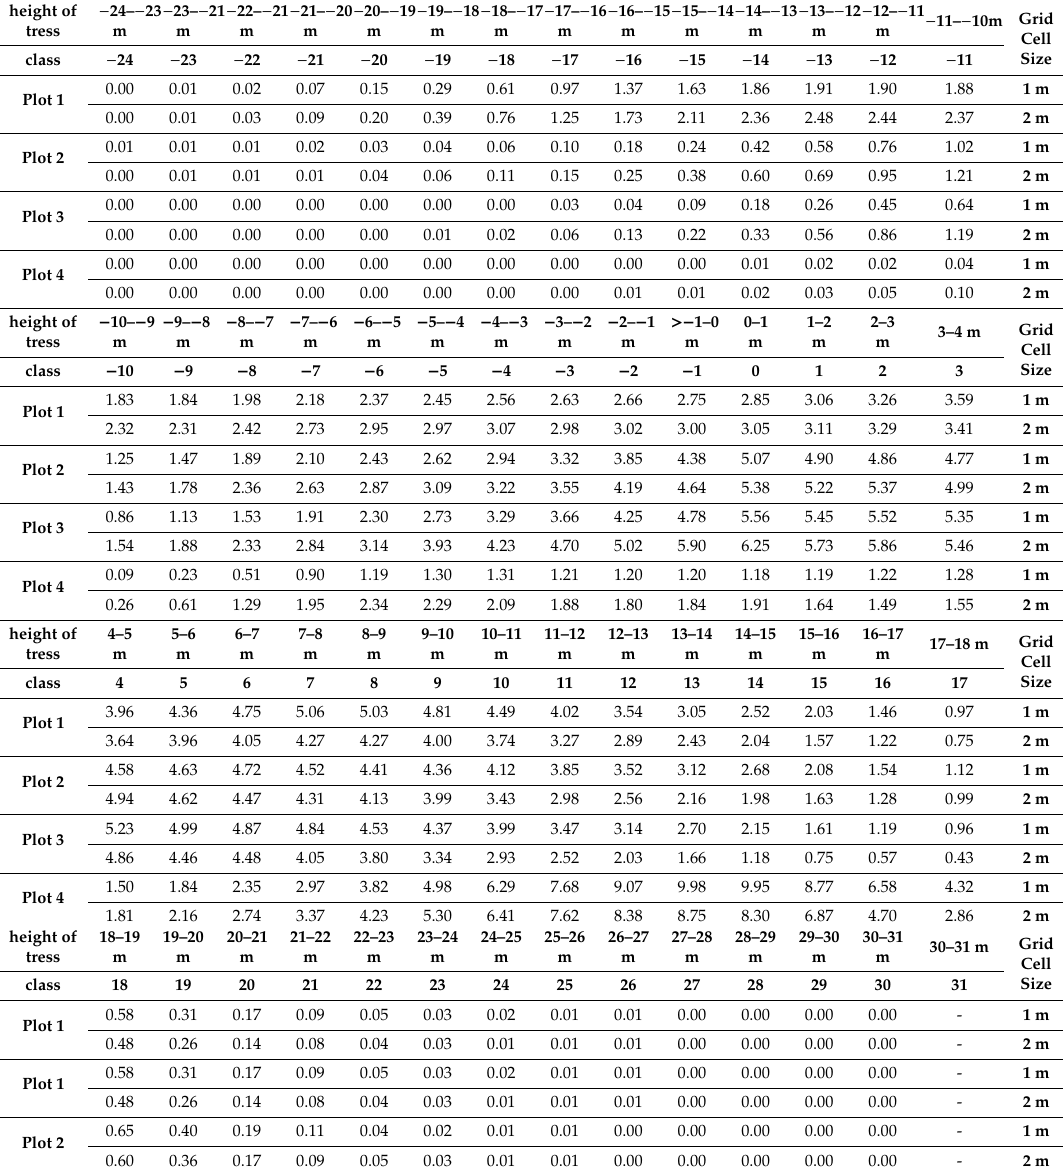
Table 3. The height structure changes in the investigated plots. The data in the table represent the percentage change in the forest cover structure. The table contains the percentage change of classes for plots developed for a grid cell size of 1 m and 2